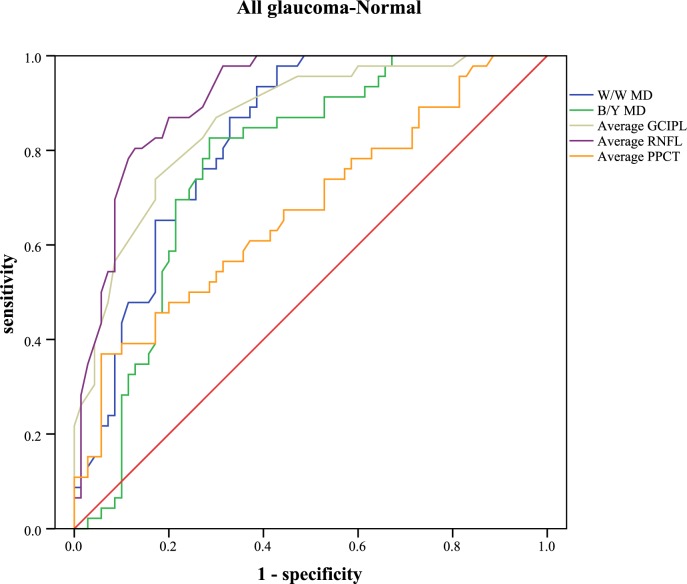
ROC curves for visual field indices and OCT parameters to discriminate glaucomatous eyes from normal eyes.